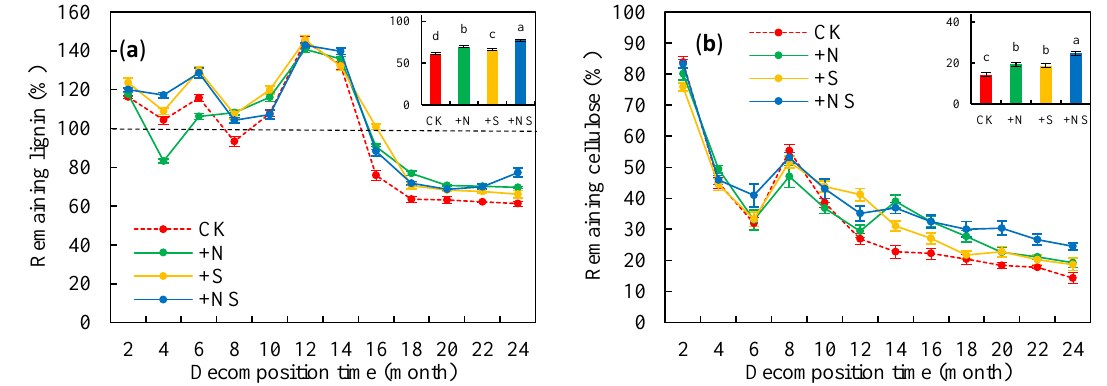
Figure 3. Remaining litter (% of the initial amount) lignin ( a ) and cellulose ( b ) during the decomposition process. Values are the averages of three plot replicates ± standard deviations. Different lowercase letters in the histogram denote significant differences between distinct treatments at the end of this experiment based on one-way ANOVA ( p < 0.05). The abbreviations for the treatments are defined in Figure 2.